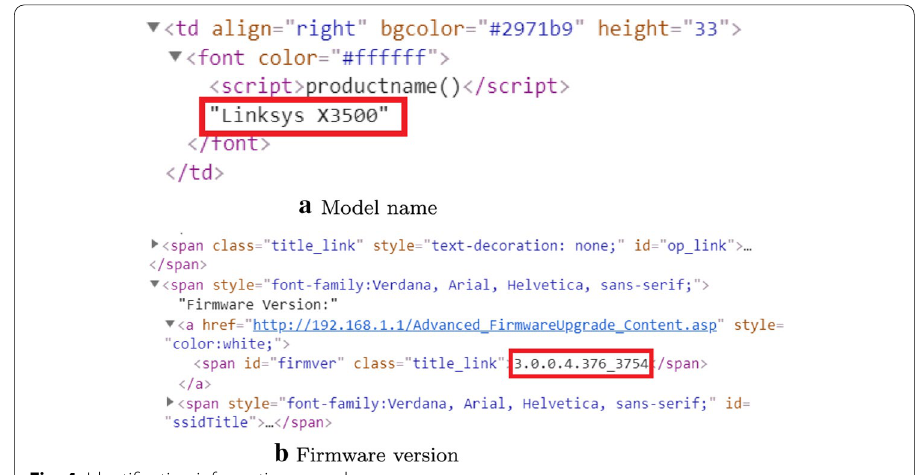
Fig. 4 Identification information on